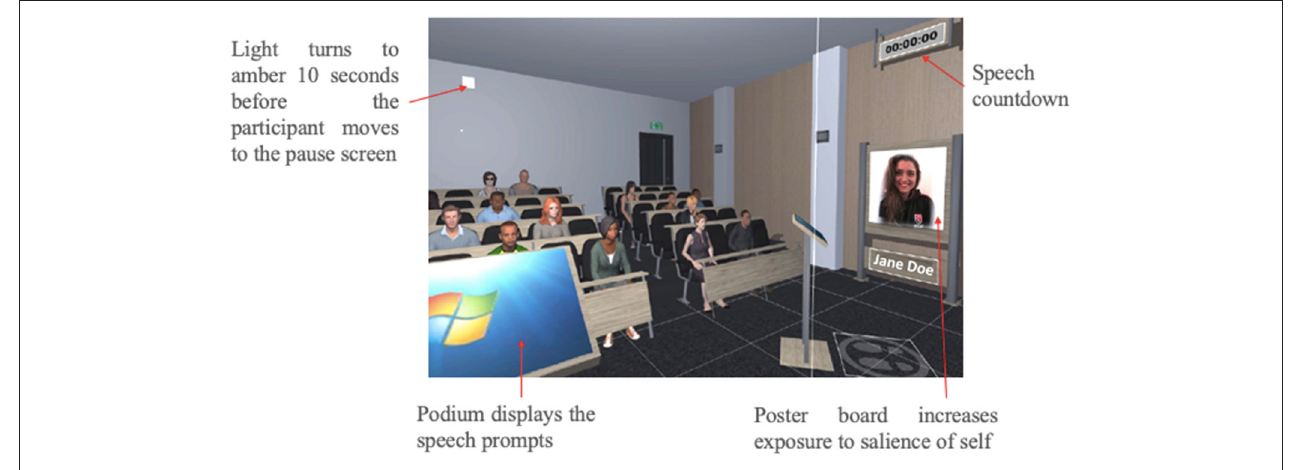
FIGURE 1 | Display of the features of the virtual